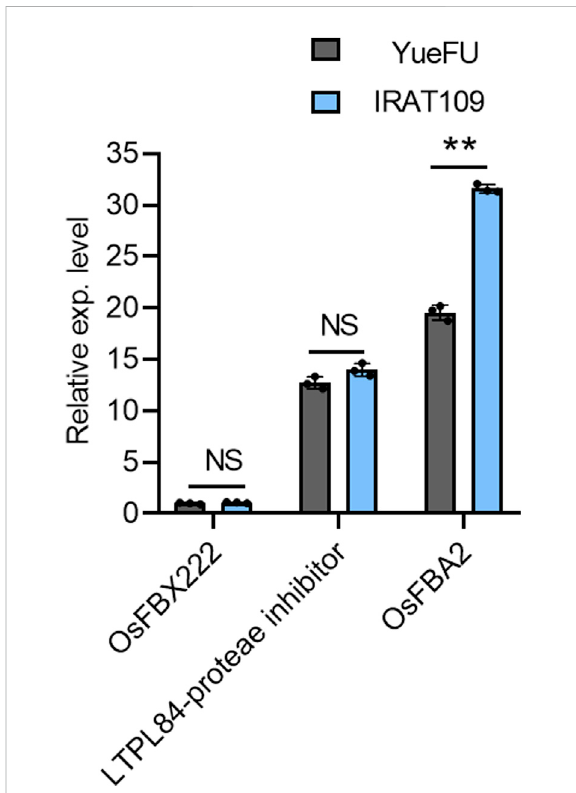
FIGURE 4 Gene expression analysis of three candidate genes in a pleiotropic QTL on chromosome 7 of the rice genome. NS; no signi fi cant difference, ** p < 0.01 based on two-tailed Student ’ s